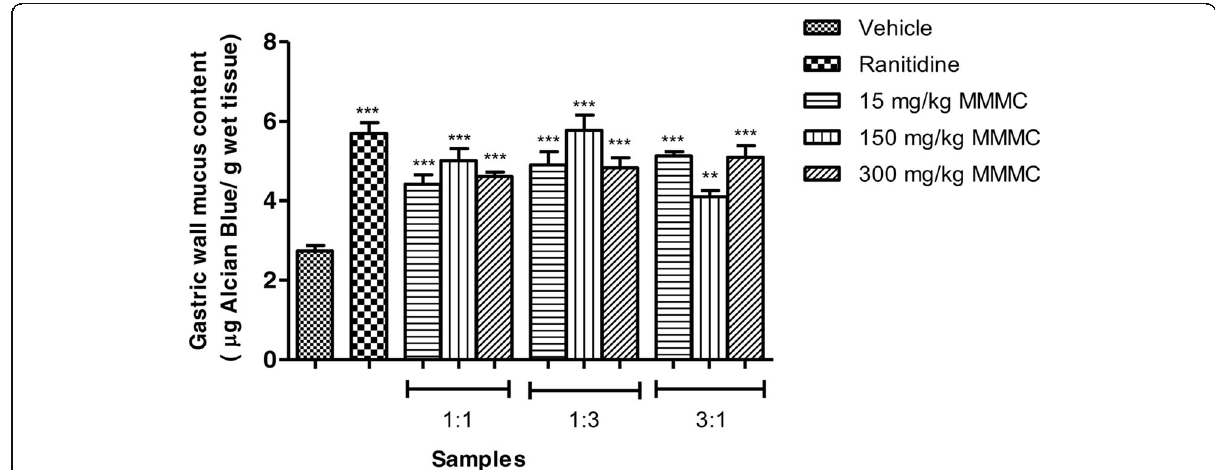
Fig. 5 Effect of orally administered vehicle (Tween 80, 2%), ranitidine (100 mg/kg) or, different ratio of 15, 150 and 300 mg/kg MMMC on gastric wall mucus production in the ethanol-induced gastric ulcer model. The gastric wall mucus content ( μ g Alcian Blue/g wet tissue) was expressed as Mean ± SEM for six animals. One way ANOVA was followed by Dunnett ’ s post-hoc test, *** p < 0.001, ** p < 0.01 vs